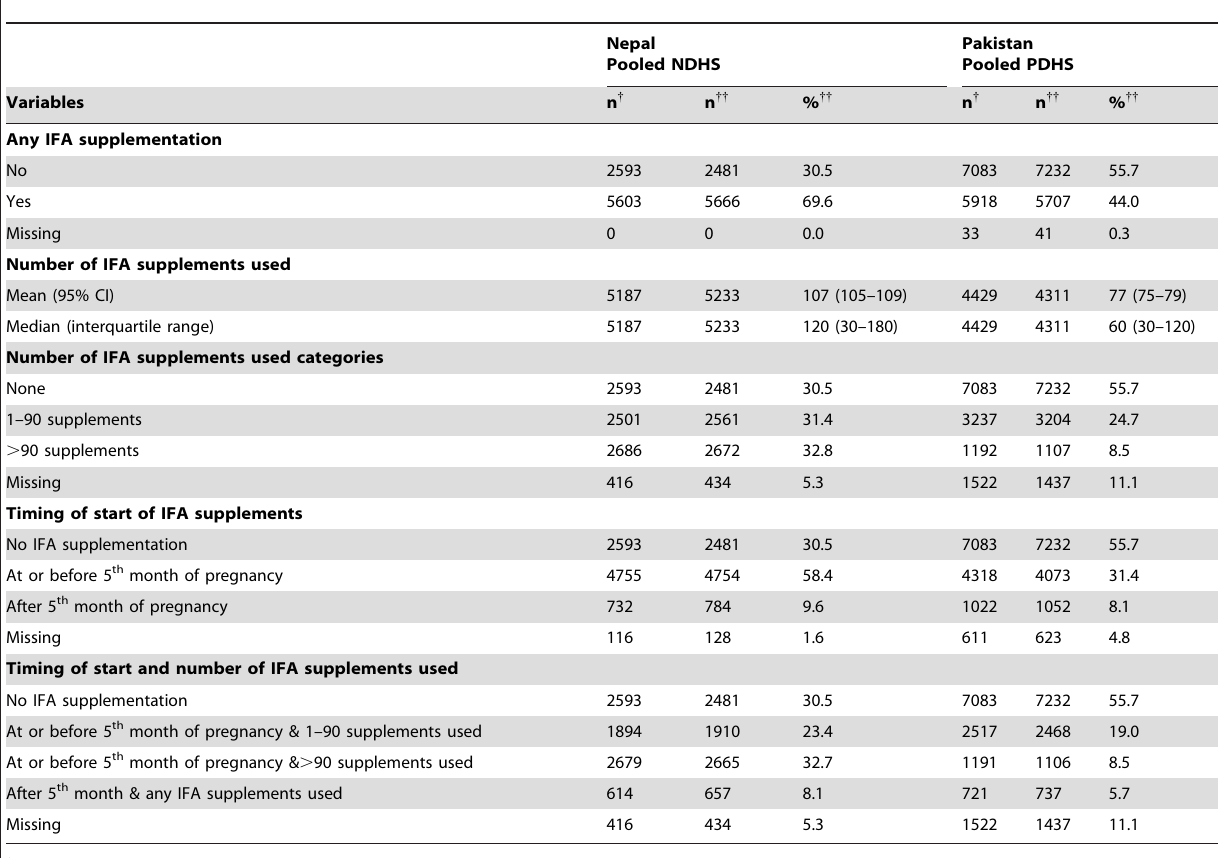
Table 2. Prevalence of any iron-folic acid (IFA) supplementation, number of IFA supplements used, timing of start of IFA supplements and a combination of timing of start with number of IFA supplements used in Nepal and Pakistan.